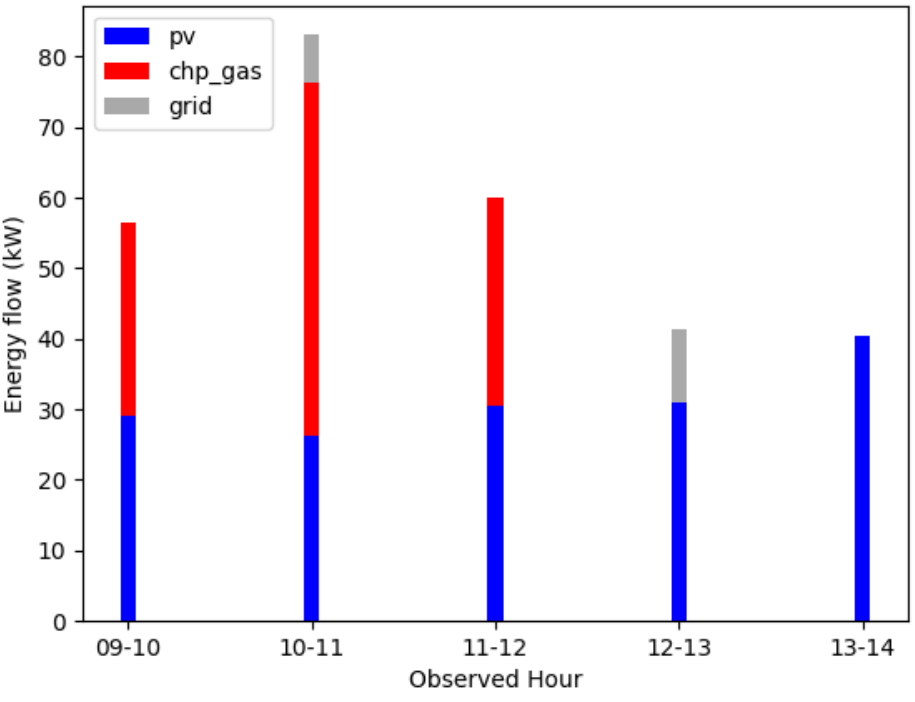
Figure 5. Example energy flows from optimised operation